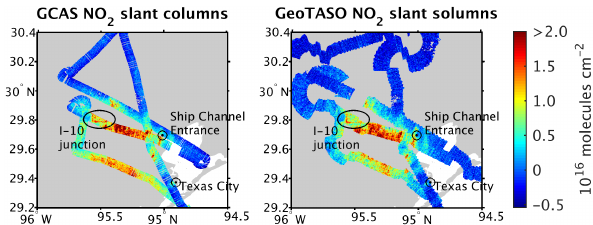
Figure 15. GCAS and GeoTASO retrieved NO 2 slant columns at 250m × 500m resolution during their first Houston overpasses on 13 September 2013 between 09:00 and 10:20LT (LT=UTC − 5h).